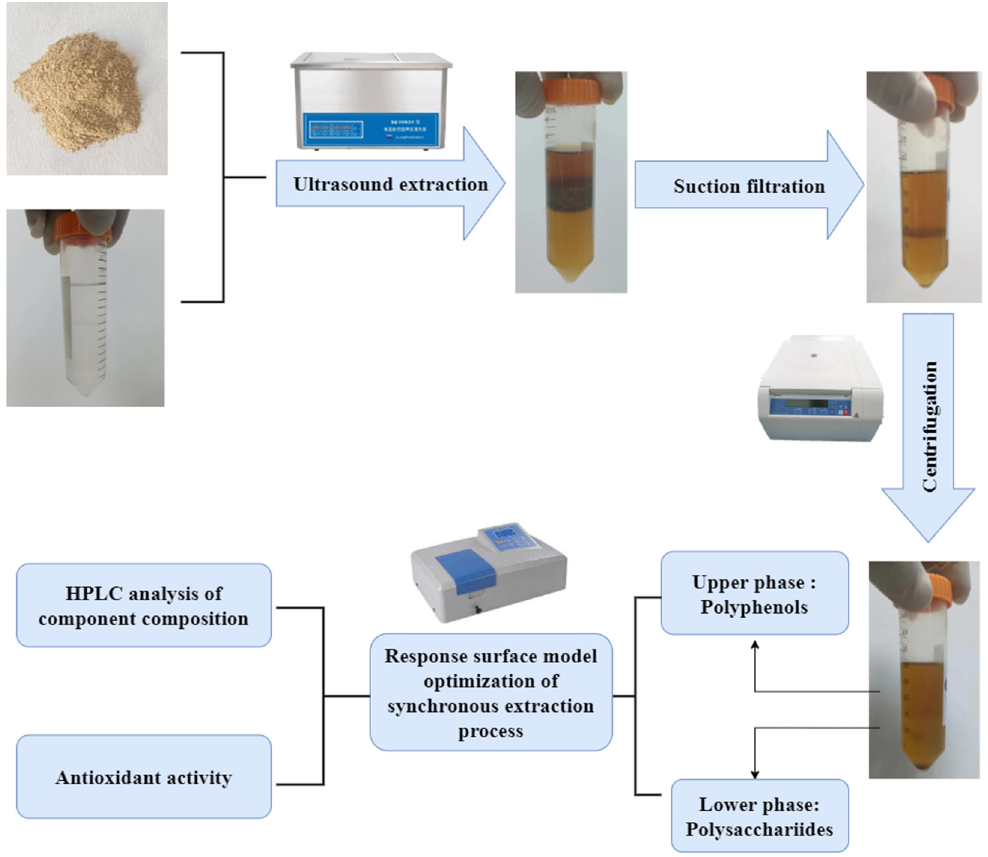
Figure 5. The synchronous extraction process for carbohydrates and polyphenols from artichoke bud.